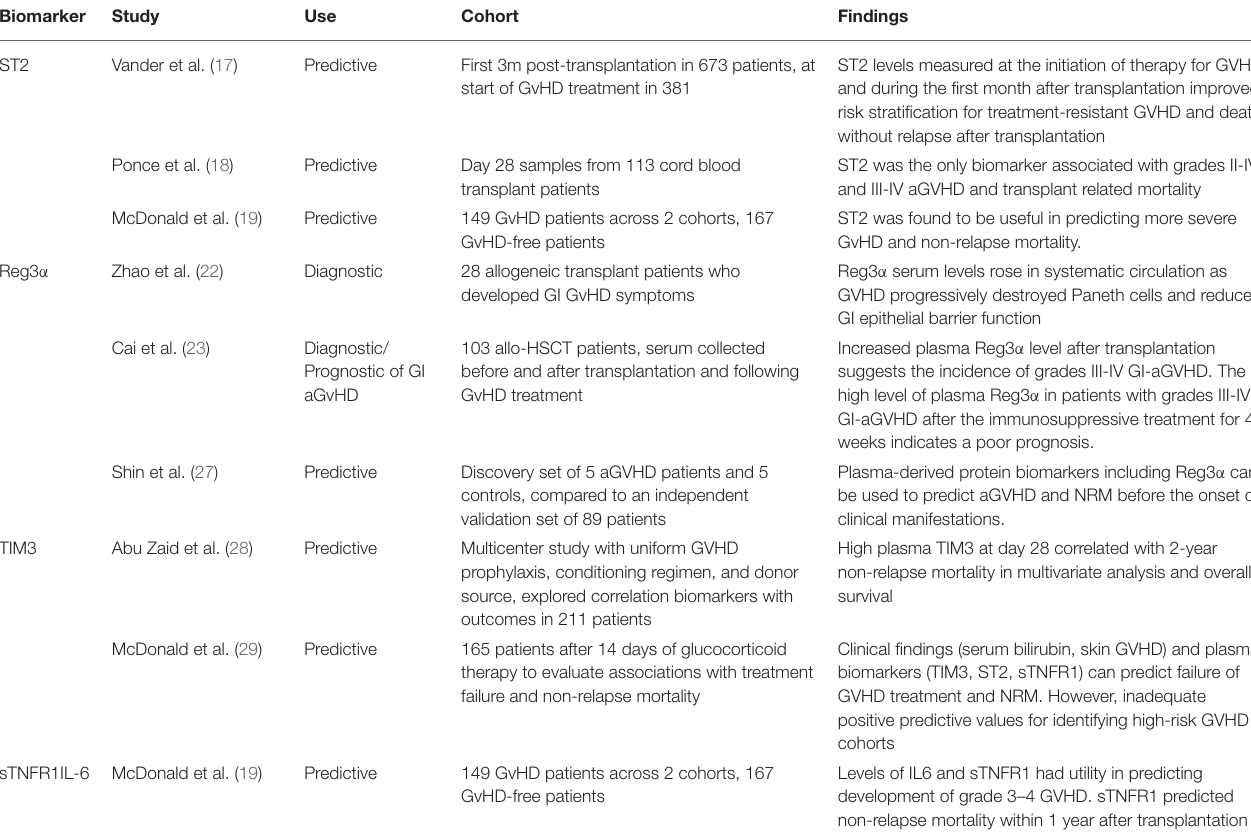
TABLE 1 | Summary of biomarkers in acute